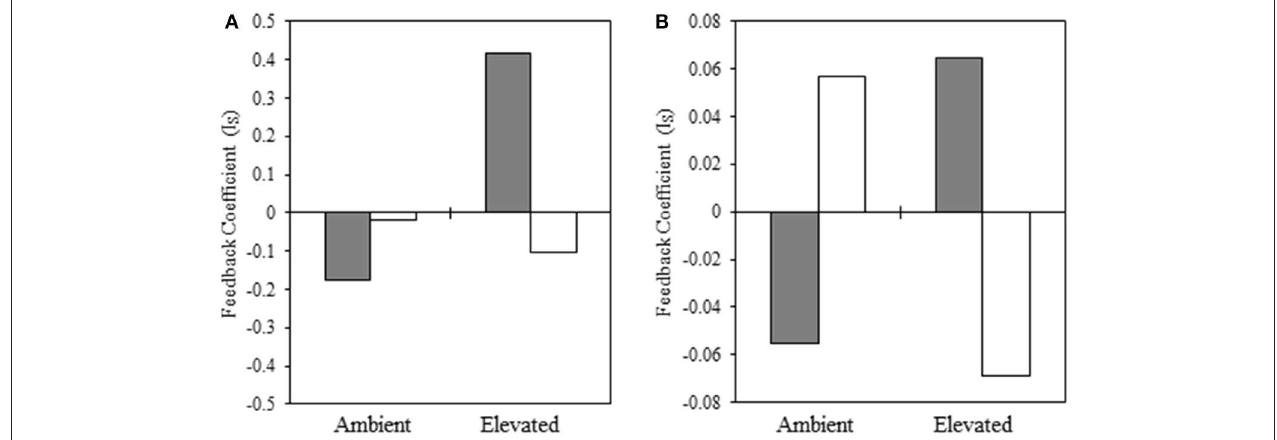
FIGURE 4 | Interaction coefficient for PSF related to biomass production of native and non-native (A) warm-season and (B) cool-season grasses. Filled bars indicate inoculum from ambient temperatures and open bars represent inoculum conditioned in elevated temperatures. In each panel, the left pair of bars represent plants grown at ambient temperatures, while the right-hand pair of bars represent plants grown at elevated temperatures (Note: y-axes differ in